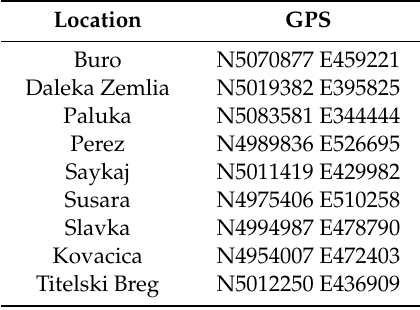
Table 5. Wild hemp ( C. sativa L.) sample collection